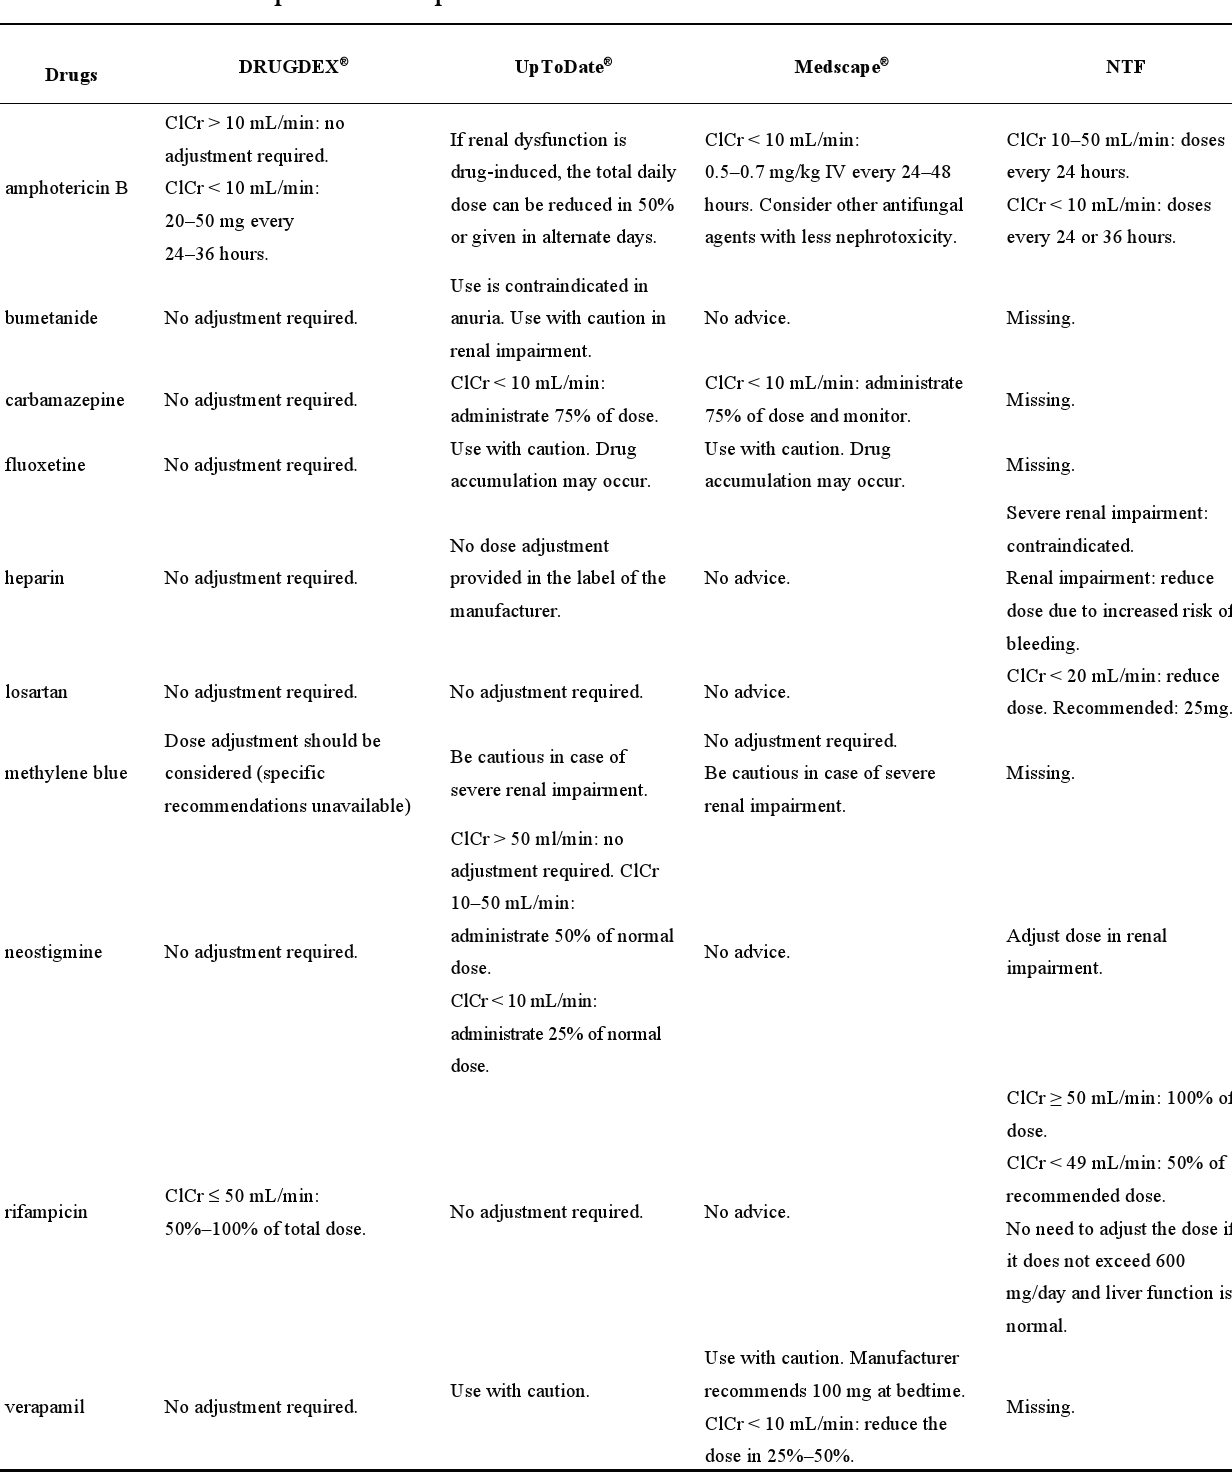
Table 5. Examples of discrepancies in recommendations across the information